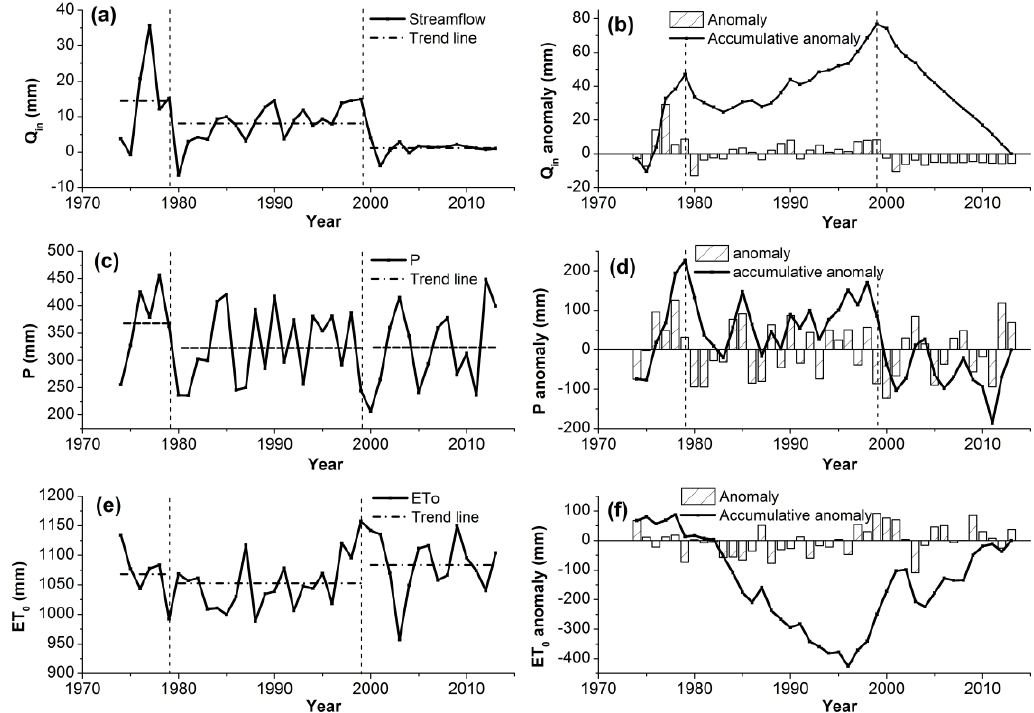
Figure 5. Variations of ( a ) annual average lake streamflow, ( b ) annual anomaly and accumulative anomaly of streamflow, ( c ) annual average precipitation, ( d ) annual anomaly and accumulative anomaly of precipitation, ( e ) annual average potential evapotranspiration, ( f ) annual anomaly and accumulative anomaly of potential evapotranspiration in the Bojiang Lake basin.